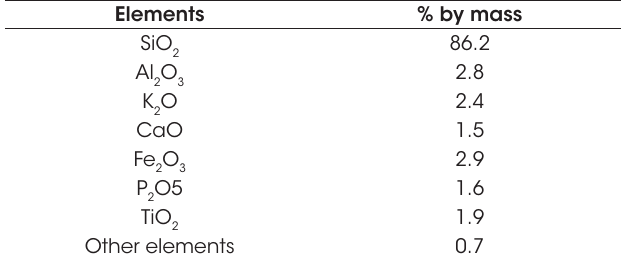
X-Ray fluorescence (XRF) results of SCBA